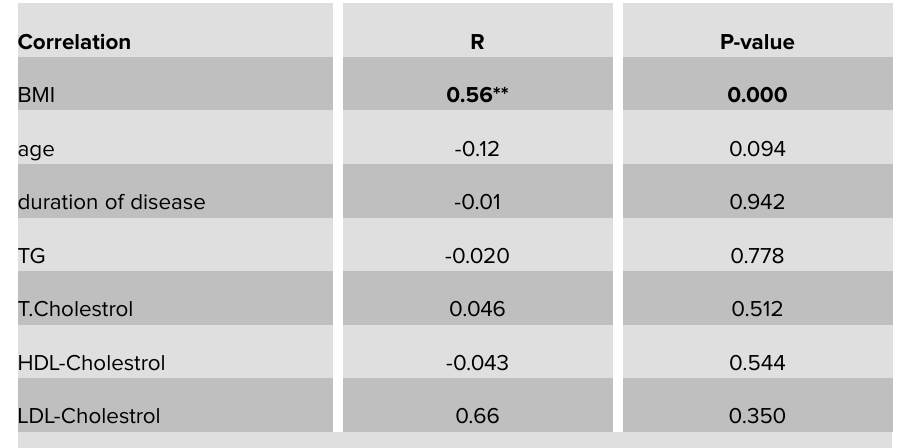
Table 5: Pearson’s correlation of hs-CRP with BMI, age, duration of disease and lipid